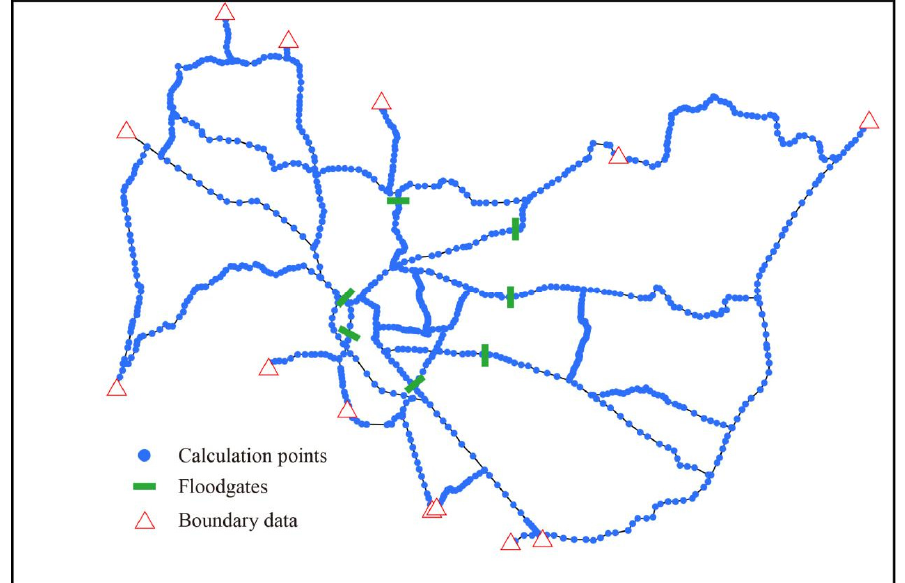
Figure 2. Generalization of the river network.